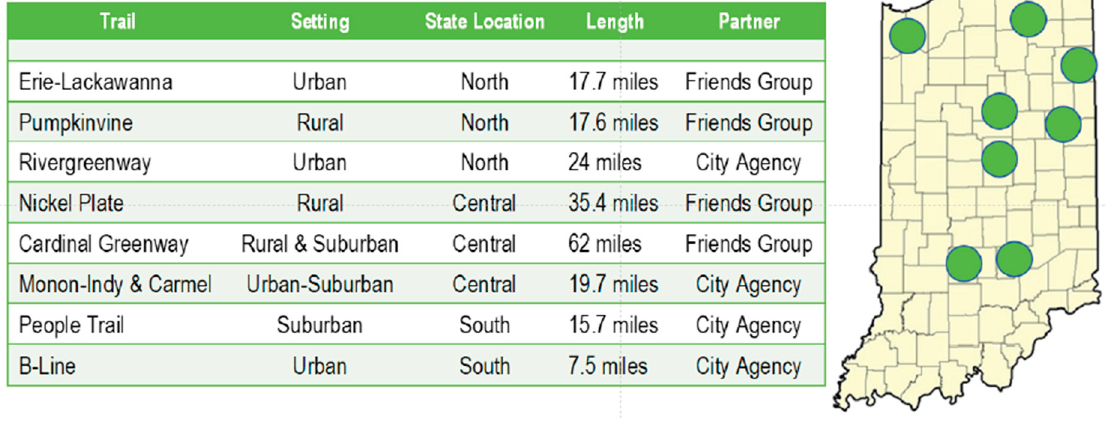
Figure 1. The map of selected trails for 2017 Indiana Trail Study.